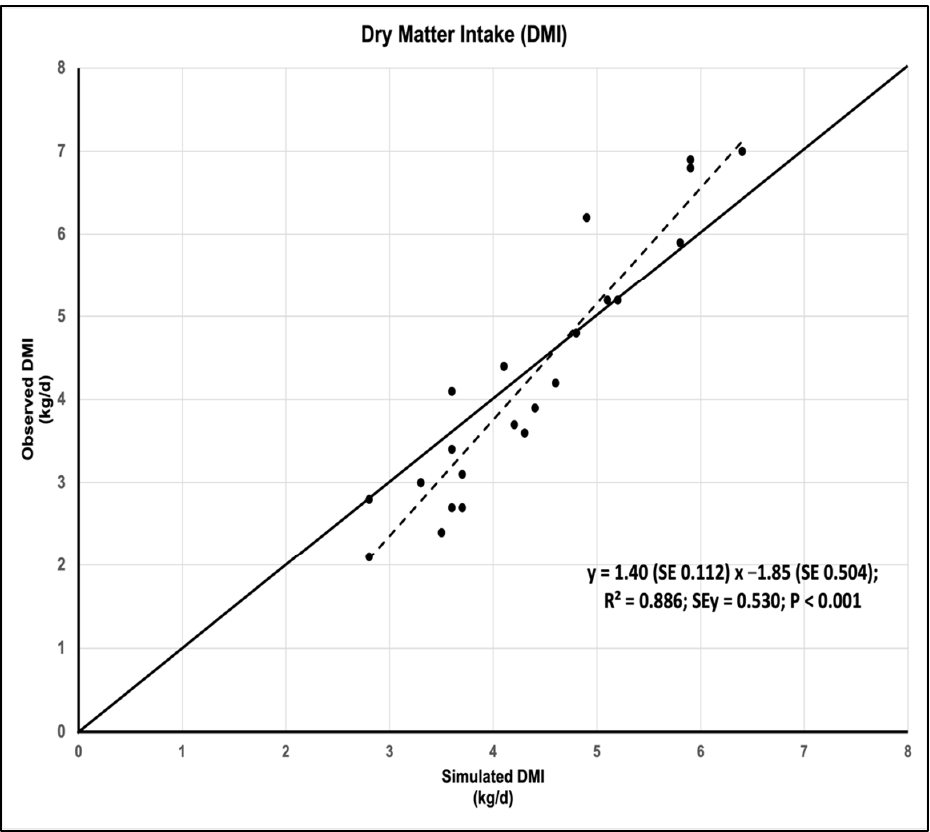
Figure 1. Relationship between the simulated and observed DMI. Table 3. Descriptors of accuracy and precision of the RUMINANT model to simulate dry matter intake (DMI) on forage diets without and with Leucaena.